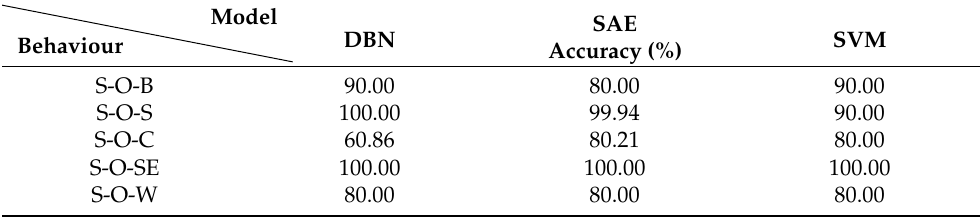
Table 1. Recognition accuracy rate of three models for five behaviours. The average error was